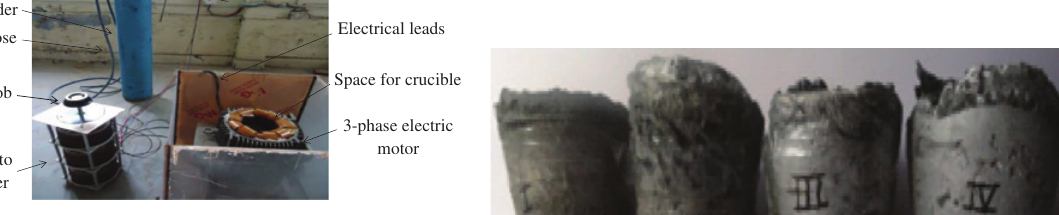
Figure 1: Experimental set up of inert gas assisted electromagnetic stir casting process. Figure 2: Cast ingots of Al 7075/Al